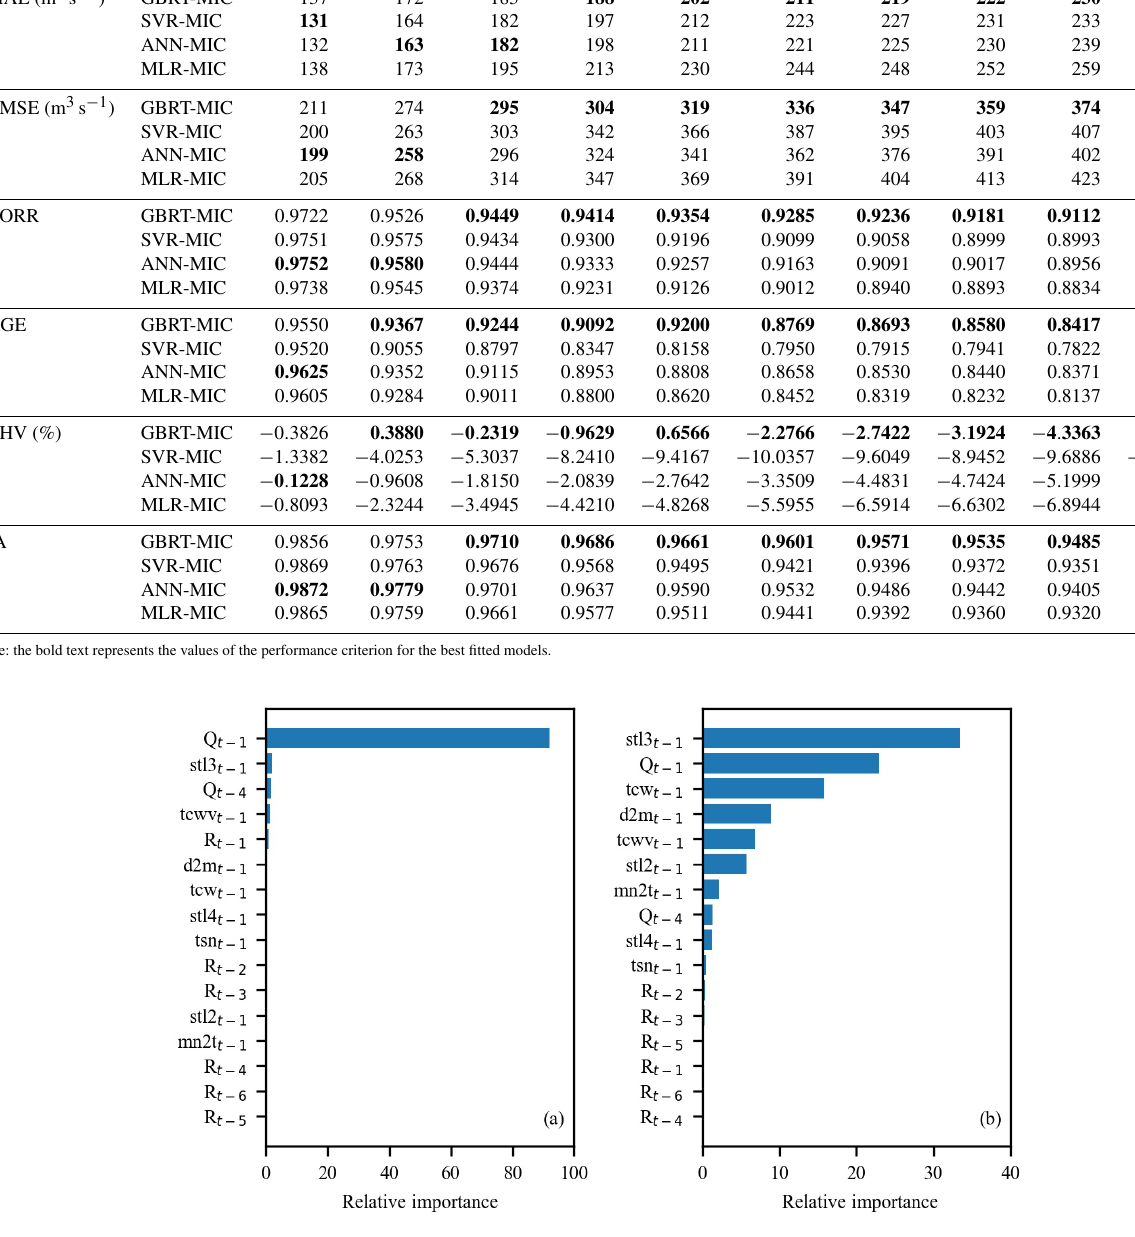
inflow and the rainfall records selected by the PACF and CCF are used as predictors to drive the models. These mod- els are compared using six evaluation criteria: the MAE, RMSE, CORR, KGE, BHV and IA. It is shown that GBRT- MIC, ANN-MIC and SVR-MIC outperform MLR-MIC at lead times of 1–10 d, and GBRT-MIC performs best at lead times of 4–10 d, especially for the forecasting of extreme val-